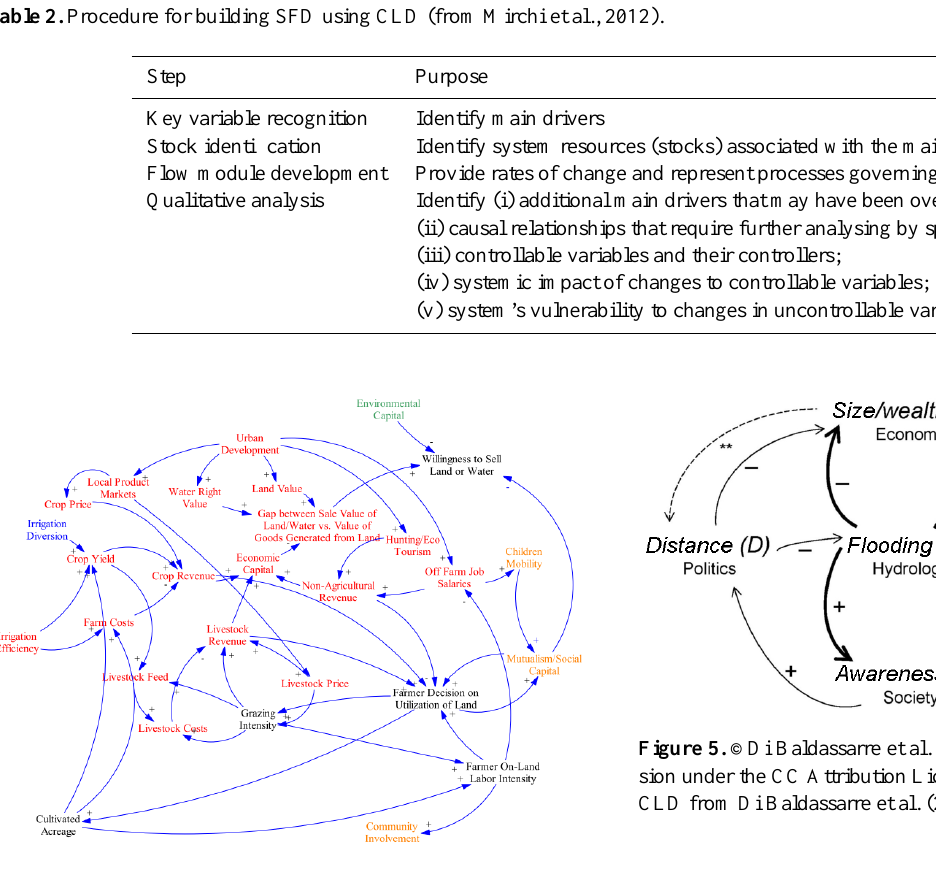
Figure 4. ©Fernald et al. (2012), reproduced under the CC Attribu- tion License 3.0. An example of a complex CLD (this is approxi- mately one quarter of the complete diagram).